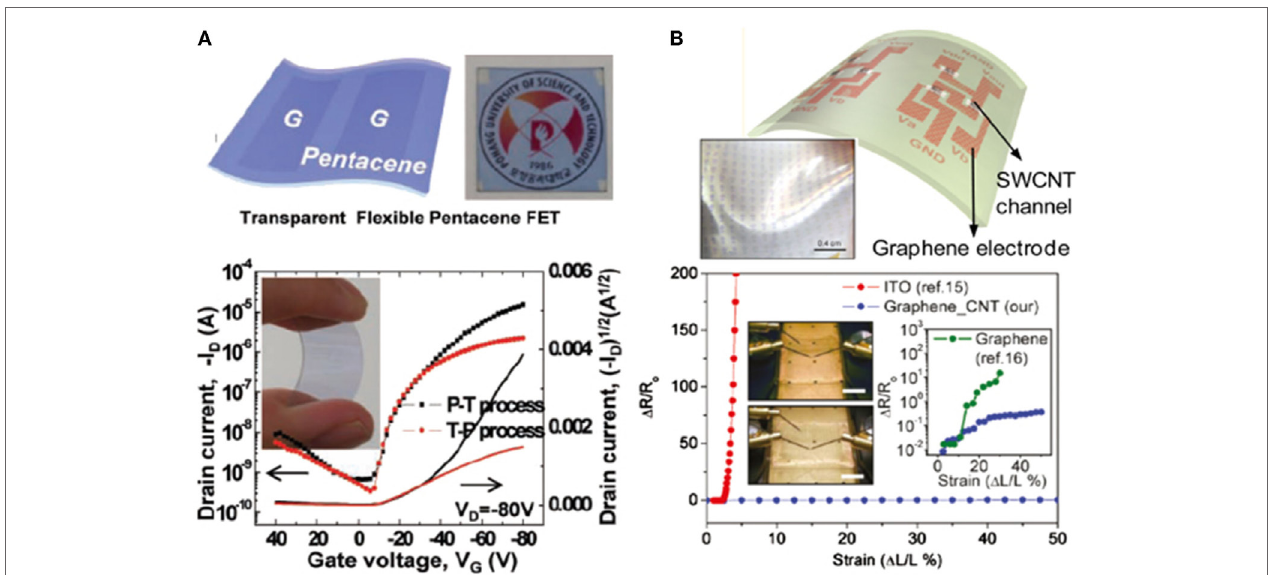
image of a mechanically stretched graphene/SWCNT composite based transistor, at the 0 and 50% strain, respectively; the right inset (B) is showing the variation of the electrical resistance w/r to the graphene number of layers. Reproduced with permission of Lee et al. (2011). Copyright 2013,